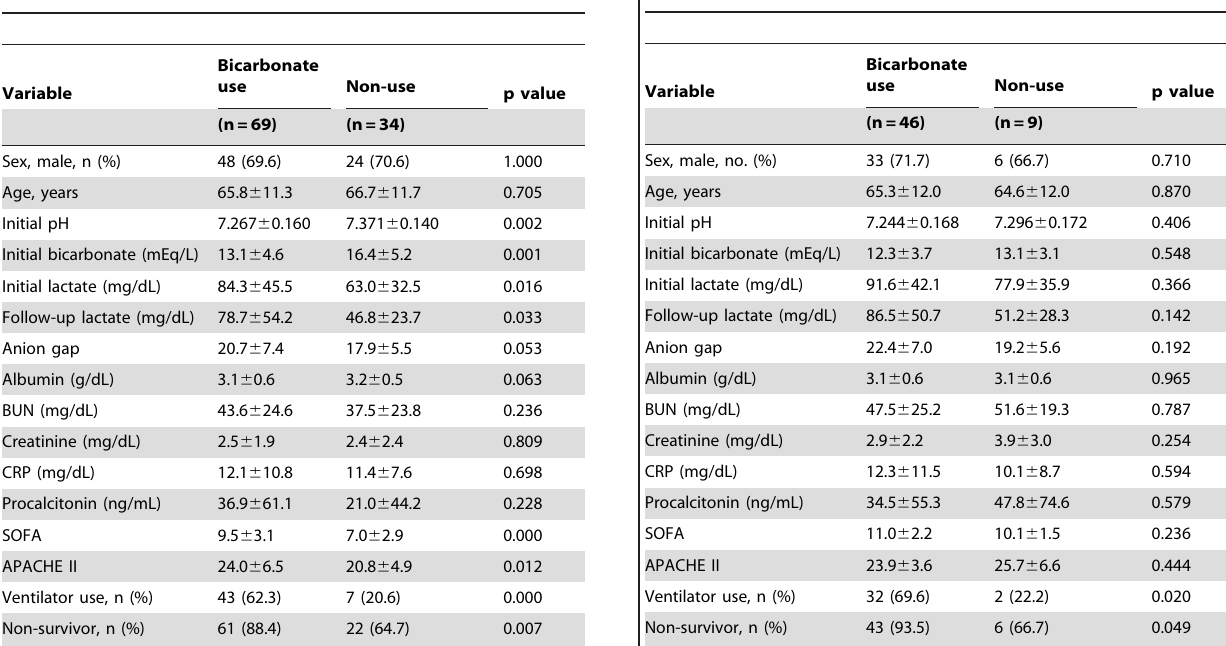
Table 3. Clinical characteristics according to sodium bicarbonate administration after excluding patients with an initial bicarbonate . 20 mEq/L and SOFA score , 8.0